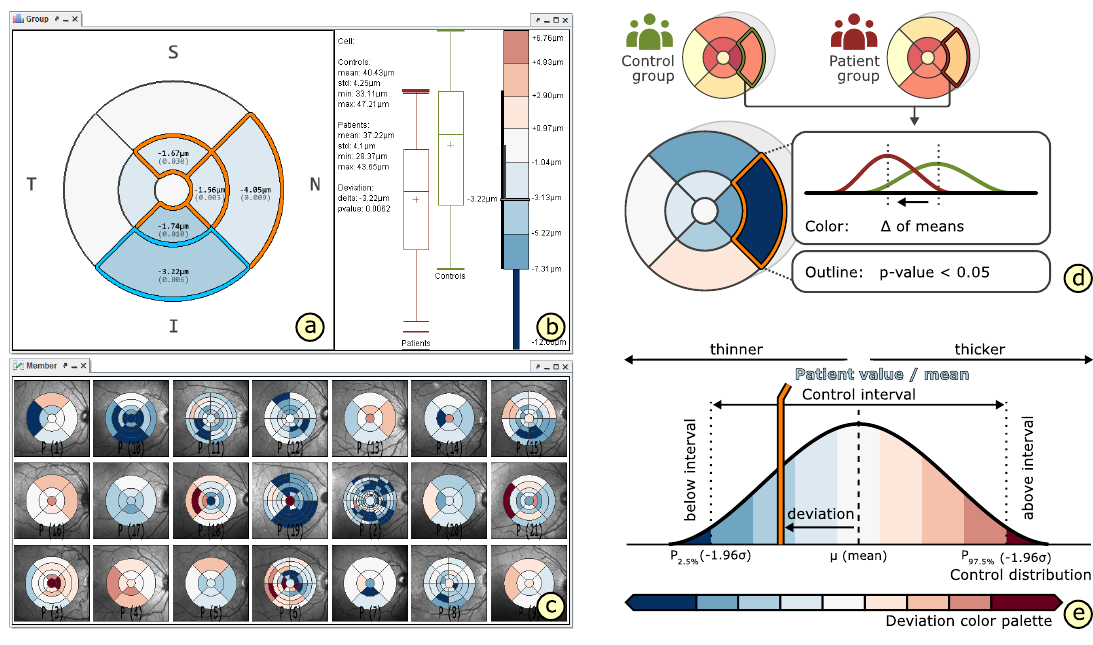
Figure 7. Comparison of grids. The top-down view ( a ) and linked measurement view ( b ) show a comparison between patients and controls via aggregated grids of both groups. The juxtaposed small multiple views ( c ) show an overview of grids of all individual patients in relation to controls. Patient values or group means are compared to the distribution of controls ( d ). A diverging color palette encodes differences per cell ( e ) and borders of cells with significant differences are highlighted